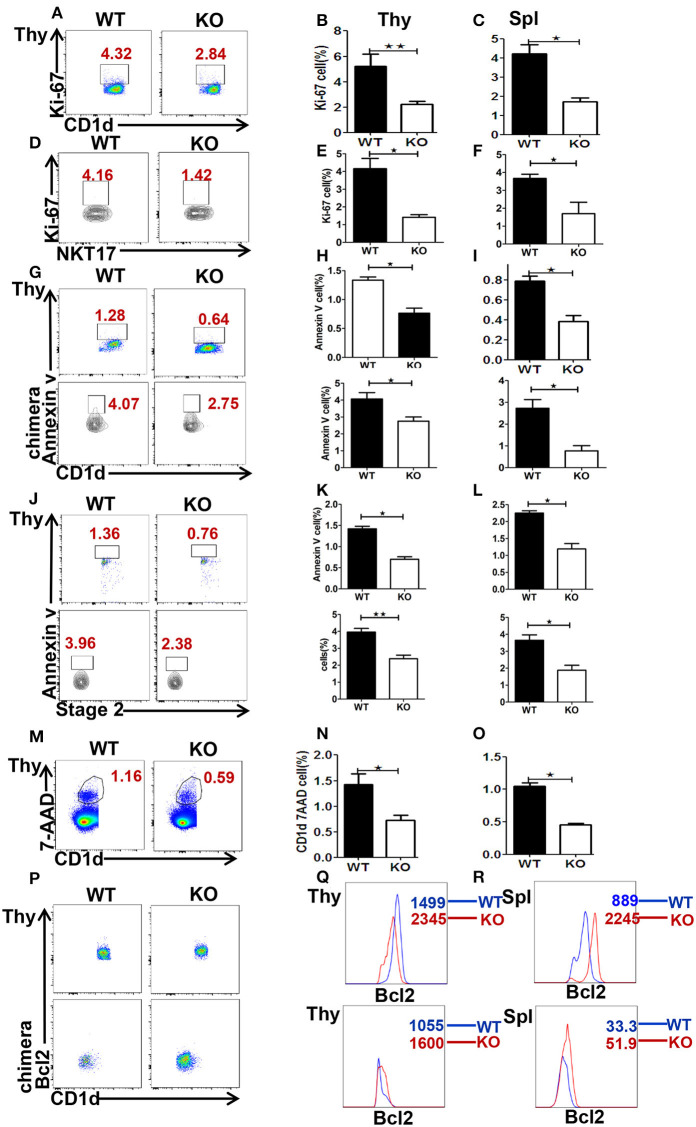
Loss of Akt2 reduces the proliferation and apoptosis of iNKT cells. (A) Flow cytometry of Ki-67 cells gated on iNKT cells in the thymus. (B,C) Percentage of Ki-67 cells in the thymus and spleen (n = 3 mice per group). (D) Flow cytometry of Ki-67 cells gated on NKT17 cells in the thymus. (E,F) Percentage of Ki-67 cells gated on NKT17 cells in the thymus (n = 3 mice per group) and spleen (n = 3 mice per group). (G) Flow cytometry of Annexin V cells gated on the iNKT in the thymus. (H,I) Percentage of Annexin V cells in the thymus and spleen of WT (n = 3), KO (n = 3), WT chimera mice (n = 4) and Akt2 KO chimera mice (n = 3). (J) Flow cytometry of Annexin V cells gated on the stage2 (CD24−CD44+NK1.1−) iNKT cells in the thymus of WT, KO, and chimera mice. (K,L) Percentage of Annexin V cells of stage2 iNKT cells in the thymus and spleen of WT (n = 3), KO (n = 3), WT chimera mice (n = 4), and Akt2 KO chimera mice (n = 3). (M) Flow cytometry of CD1d cells gated on 7AAD cells in the thymus. (N,O) Percentage of CD1d cells in the thymus (n = 3 mice per group) and spleen (n = 3 mice per group). (P) Flow cytometry of Bcl2 cells gated on iNKT cells in the thymus. (Q,R) Overlaid histograms show expression of Bcl2.chimera *p < 0.05; **p < 0.01, Student's t-test.